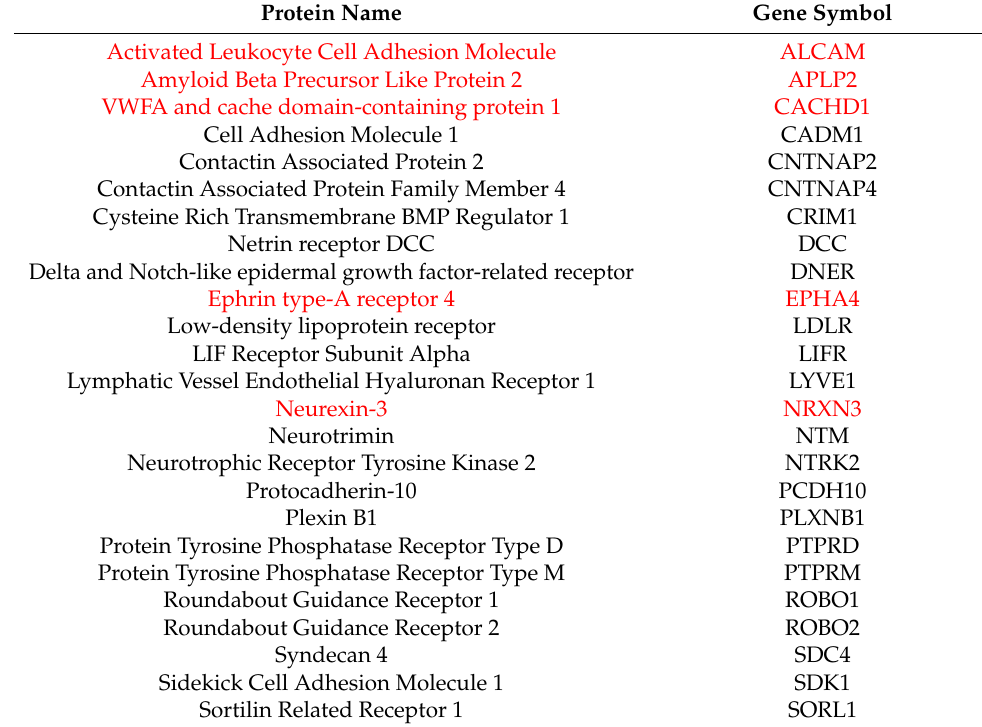
LIF Receptor Subunit Alpha Lymphatic Vessel Endothelial Hyaluronan Receptor